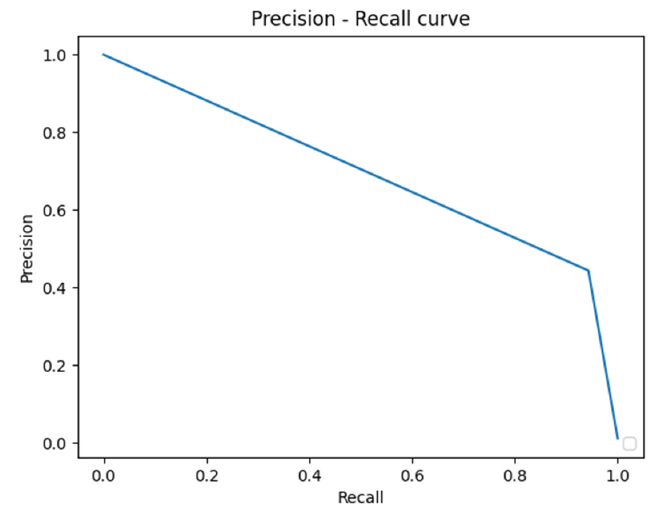
Figure 4. Precision–Recall curve.